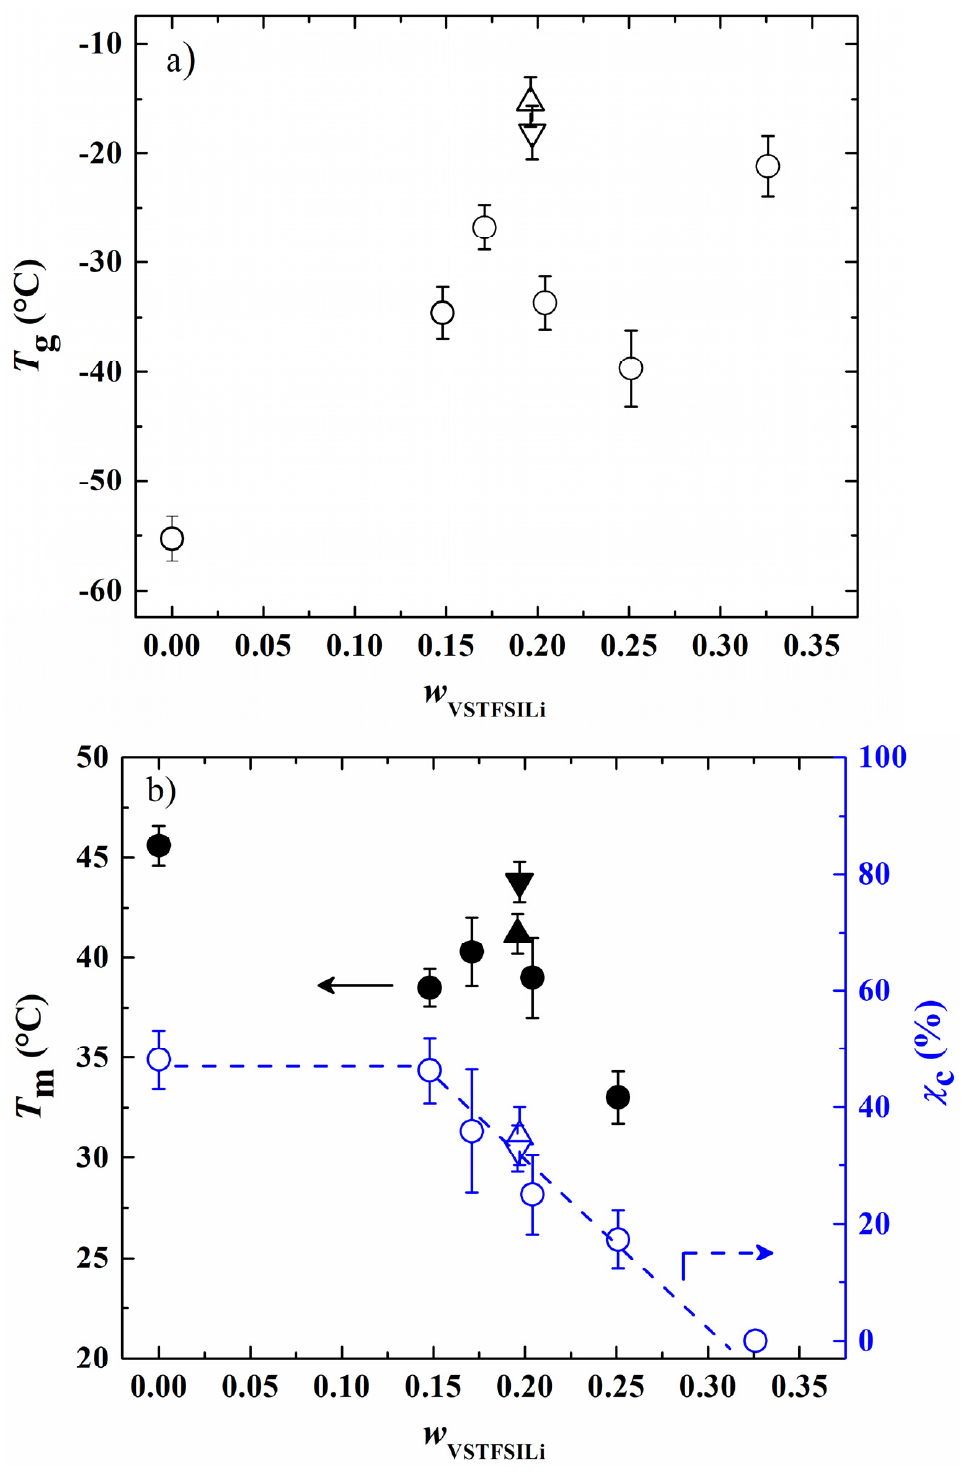
Figure 4. ( a ) Glass transition temperature ( T g ), and ( b ) melting temperatI ( T m ) and degree of crystallinity ( χ c ) as a function of w VSTFSILi . The circle symbols correspond to the HySI_ w VSTFSILi electrolytes while the up and down triangles correspond to HySI_20_TEOS and HySI_20_TEMS, respectively. In figure ( b ), filled and open symbols correspond to T m and χ c , respectively. The dash lines are eye guides.